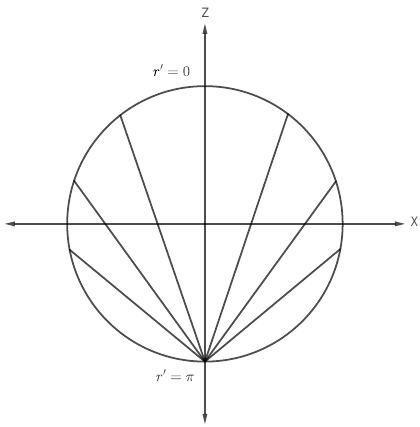
= 0) 0 . Changing φ corre- 2 + 1 0